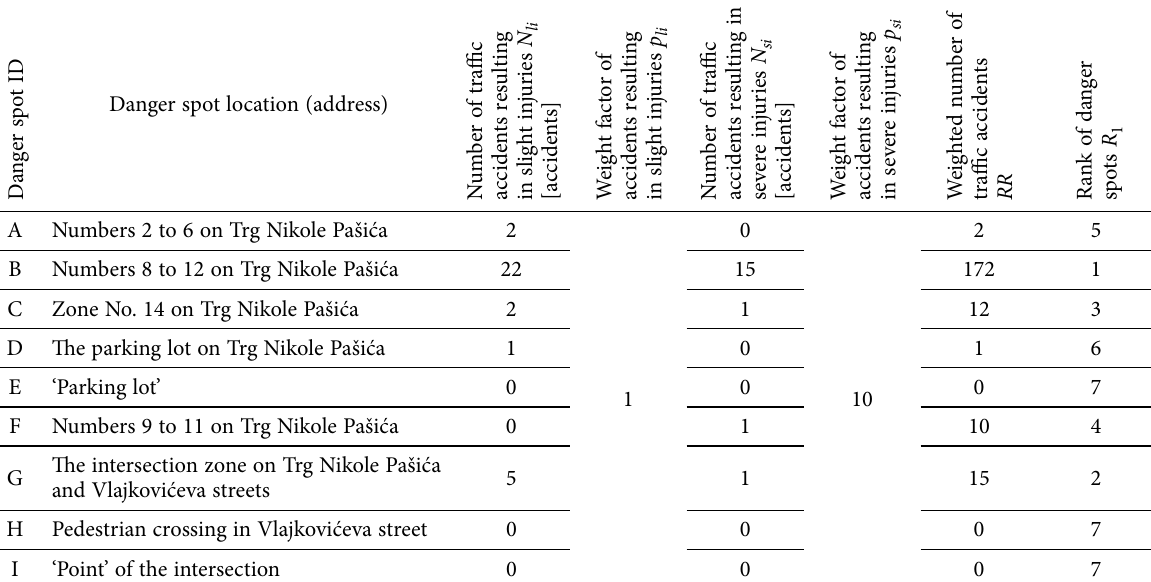
Table 1. Ranking danger spots based on the analysis of traffic accidents (Vujanić et al.